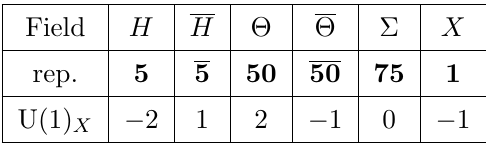
Table 2 . The (cid:12)eld content in the Higgs